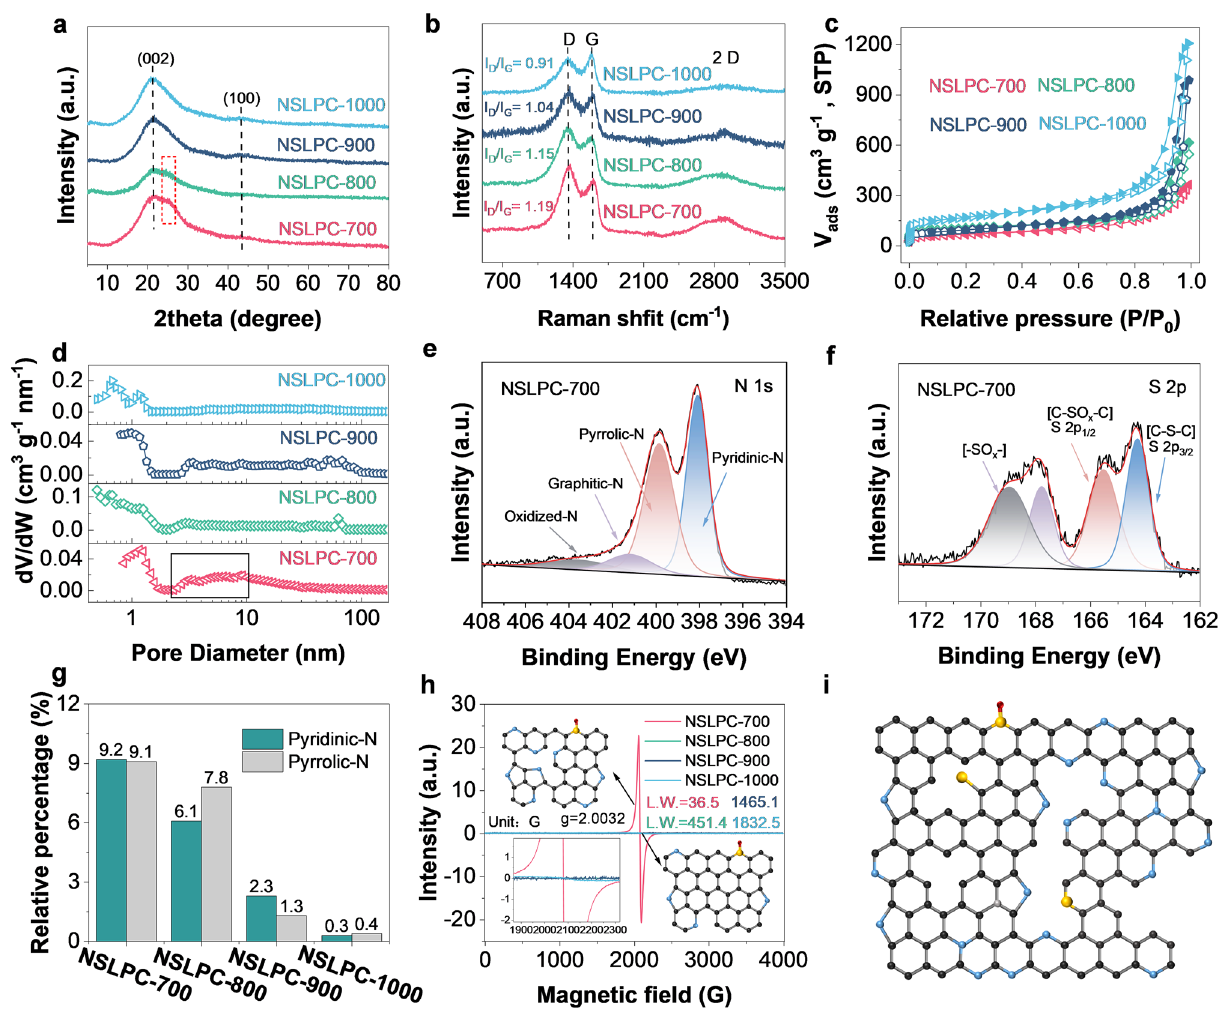
Fig. 4 a XRD patterns. b Raman spectra. c N 2 adsorption/desorption isotherms, and d pore size distribution of the NSLPCs. High-resolution e N 1 s and f S 2 p XPS spectra of the NSLPC-700. g XPS survey calculated the elemental contents of the pyridinic-N and pyrrolic-N. h EPR spec- tra of NSLPCs. i Schematic illustrating a heteroatom-doping configuration in